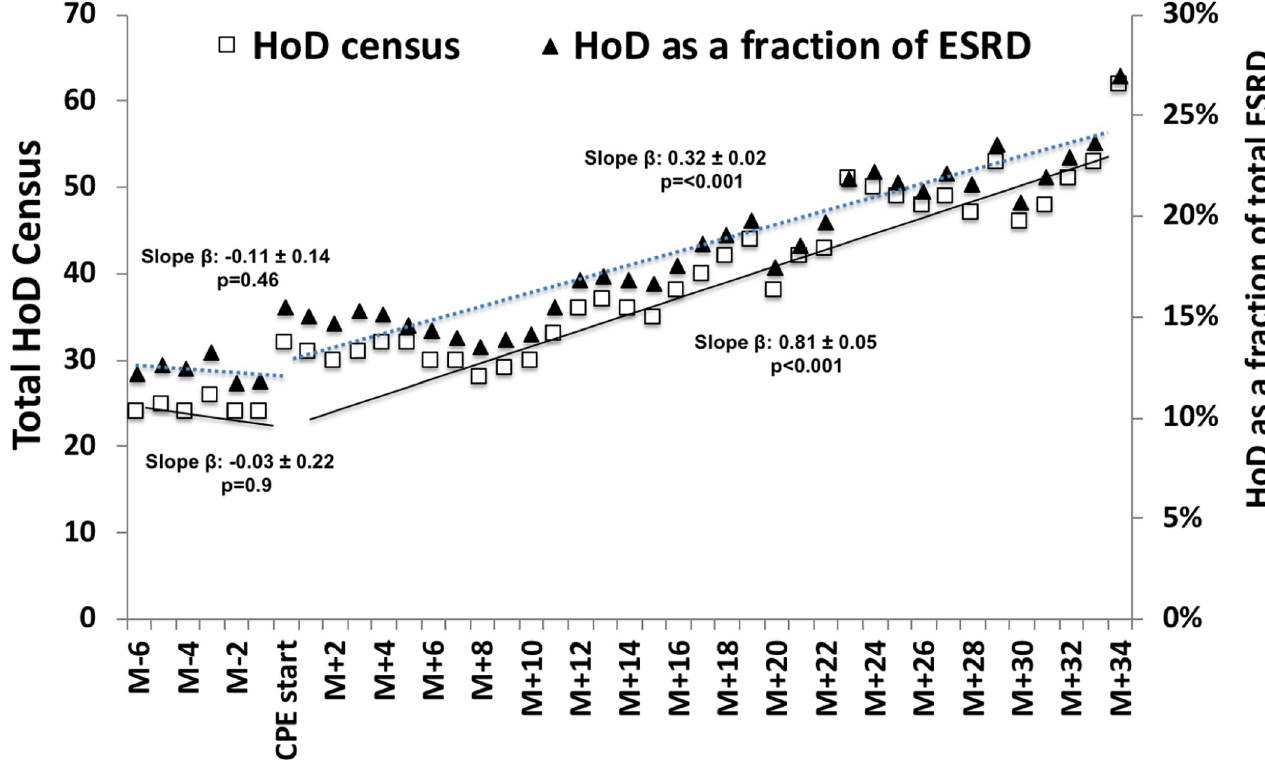
Fig 4. Growth of HoD utilization before and after the initiation of CPE program. Fig 4 represents the HoD utilization before and after the initiation of CPE program. The choice and utilization data in the text represents the initial 18 months study period for which the data is available. The extended 34 month graph is meant to represent the ongoing impact of CPE program on the HoD growth beyond the study